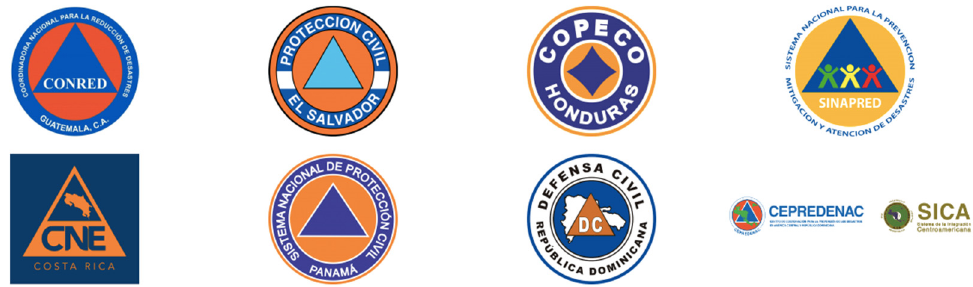
Figure 1. Governing Body Members of the Coordination Center for Disaster Prevention in Central America [5]. The entities act individually in their countries of origin, but during emergencies they weave regional support networks, involving the availability of human resources and physical assets to counter socio-environmental